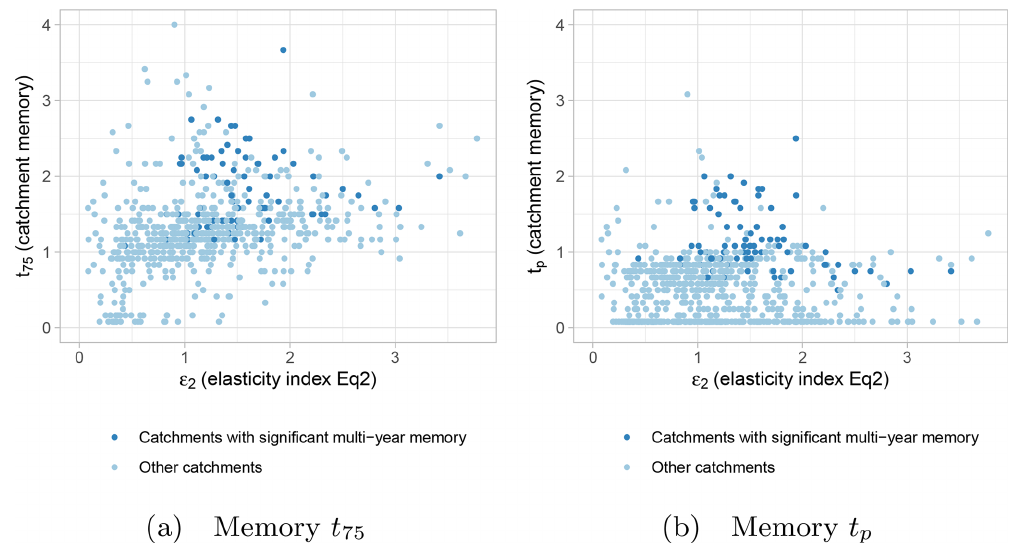
Figure A1. Relation between elasticity index ( ε 2 ) of Eq. (2) and catchment memory assessed by t 75 and t p